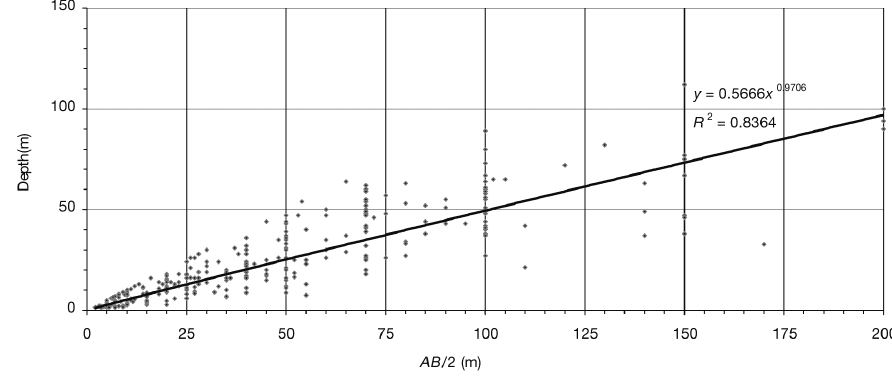
Fig. 3. Correlation between depth of current penetration and length of current